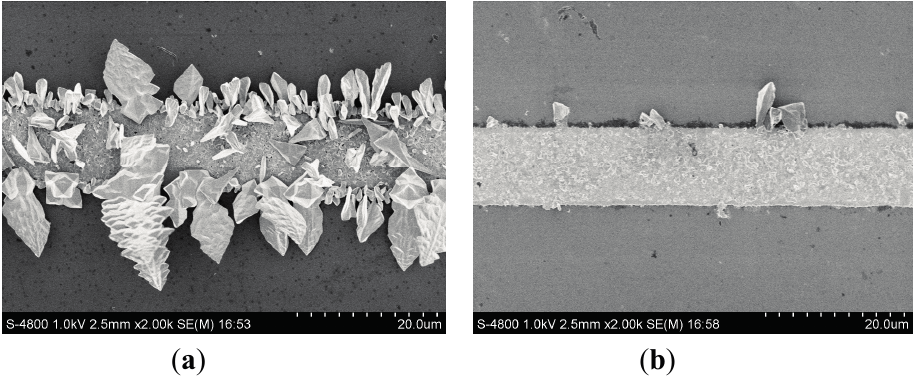
Figure 5. SEM images of ( a ) freshly deposited tin layer ( b ) tin layer after several times of LSV analysis.